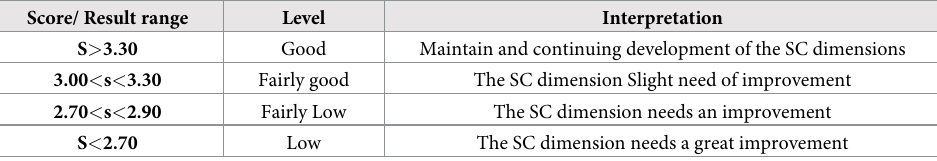
Table 2. Criteria for interpreting the Nordic Safety Climate Questionnaire (NOSACQ-50) results [37].